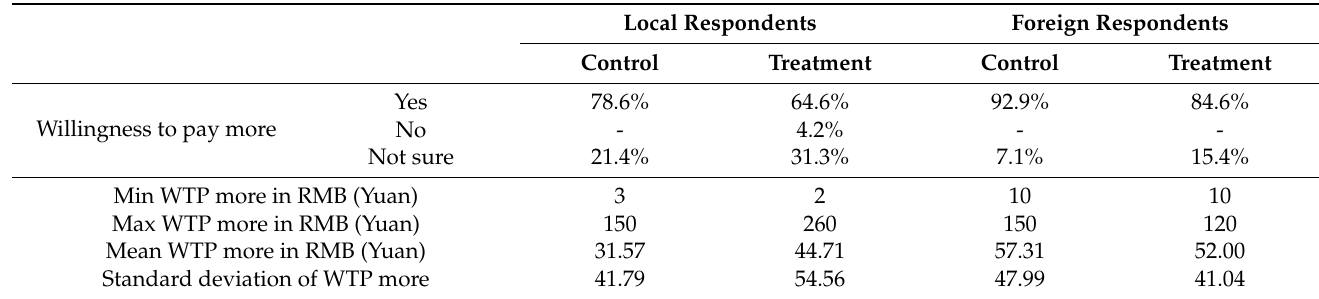
Table 5. Respondent stated WTP more by group.